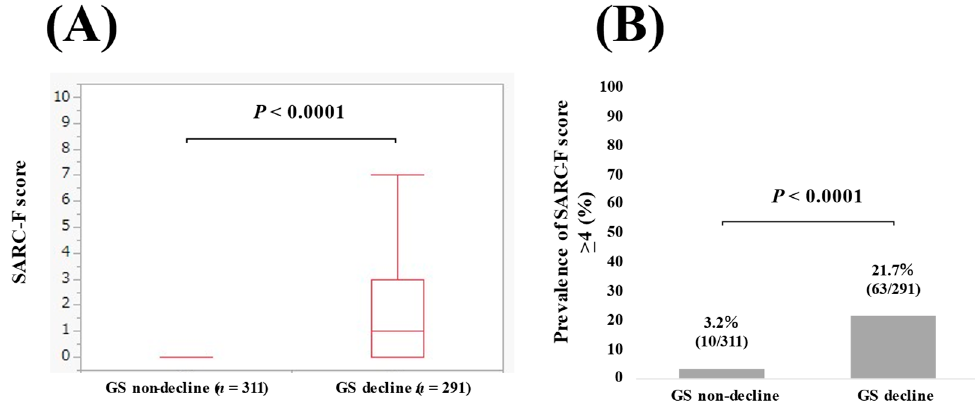
Figure 2. ( A ) The SARC-F score in patients with the GS non-decline ( n = 311) and the GS decline ( n = 291). ( B ) The percentage of the SARC-F score ≥ 4 in patients with the GS non-decline and the GS decline.